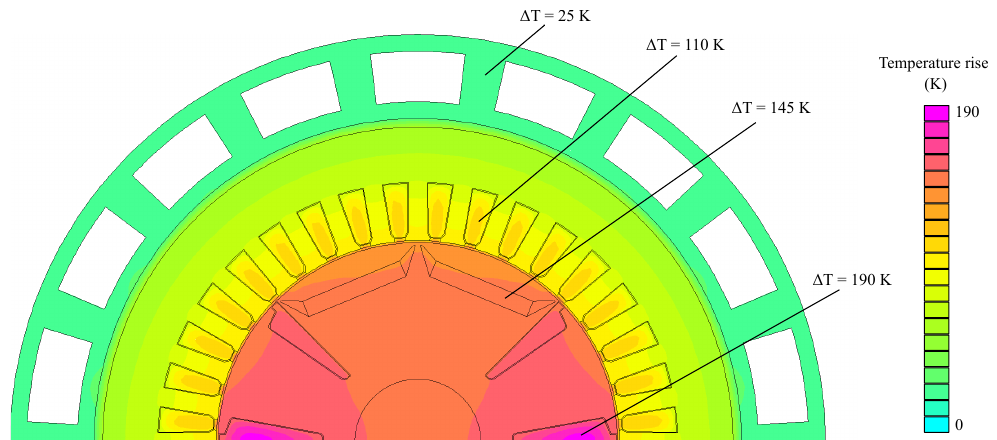
Figure 36. Temperature increase map for the HEPM motor with a water cooling system.